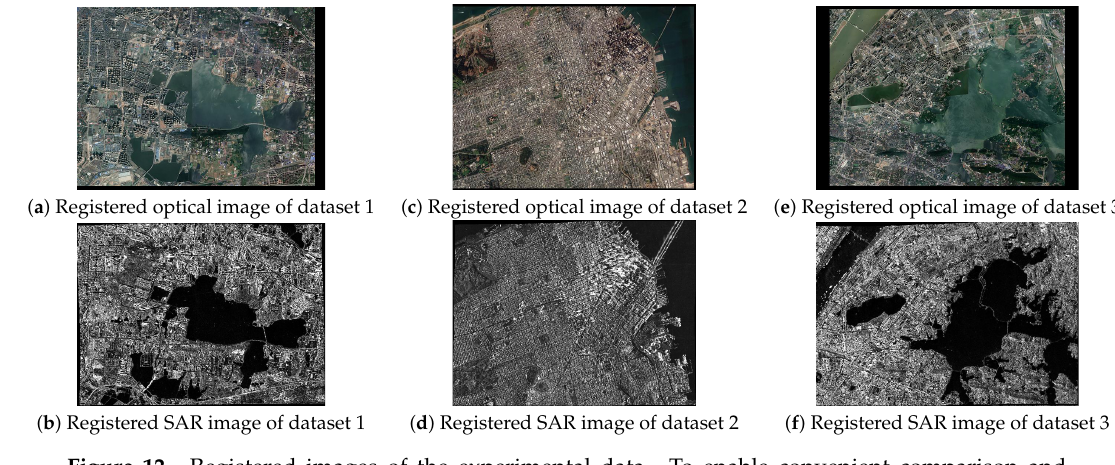
Figure 12. Registered images of the experimental data. To enable convenient comparison and observation, the optical image and the registered SAR image are displayed in the same coordinate system. The black borders of optical images are the background of the coordinate